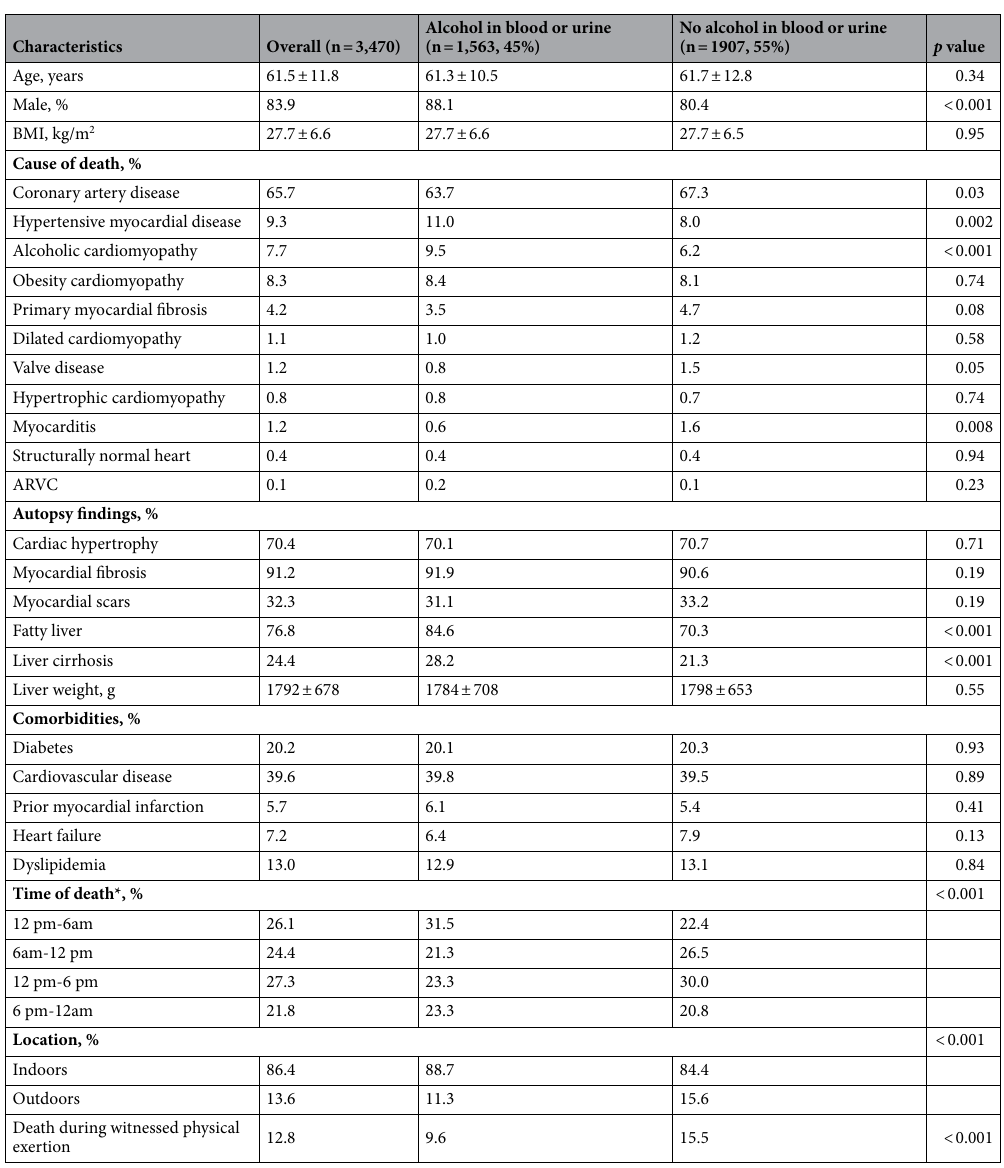
Table 2. Characteristics of sudden cardiac death victims with known blood and urine alcohol concentrations. * = Data available in 1,229 cases (498 in those with alcohol in blood or urine and 731 in those without alcohol in blood or urine). ARVC = arrhythmogenic right ventricular